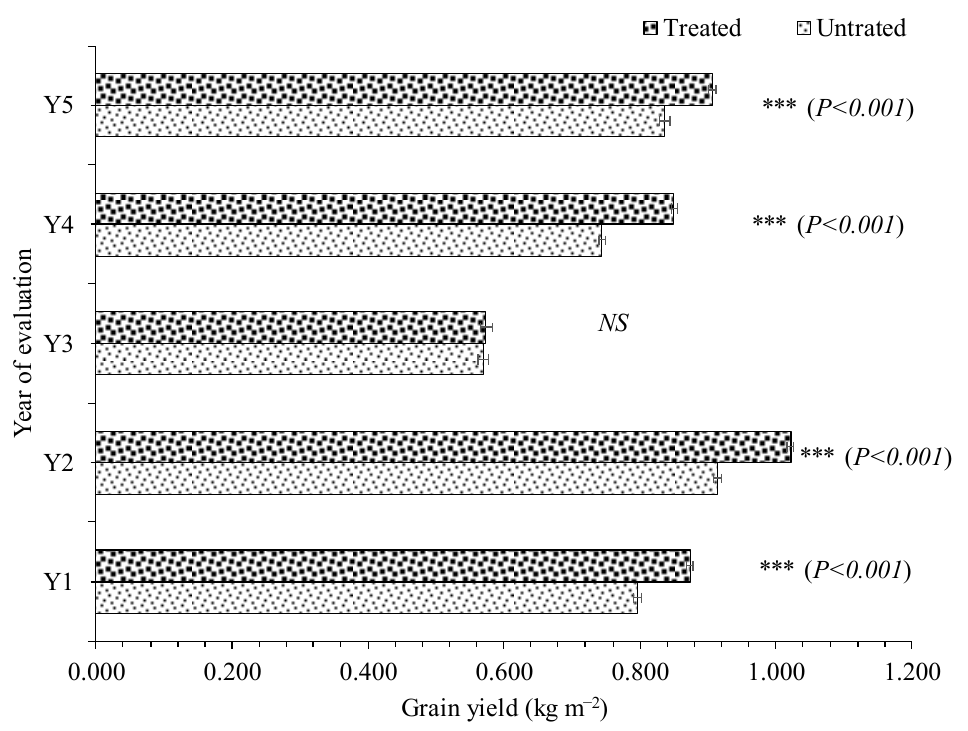
Figure 2. Influence of fungicide on mean grain yield (kg m − 2 ) of spring barley genotypes during evaluated years. (Asterisk denotes significance at the level of p < 0.001 (***). Table 2. AMMI analysis of variance for spring barley genotypes for grain yield under untreated and treated conditions. Asterisks following F values indicate significance at the level of p < 0.05 Table 1. Variation in grain yield (kg m − 2 ) across five years under treated and untreated conditions.